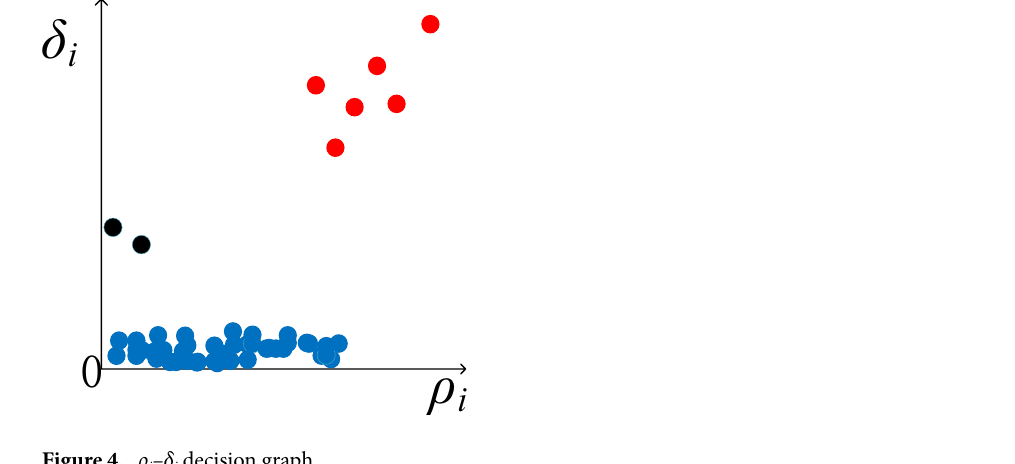
Figure 4. ρ i –δ i decision graph.